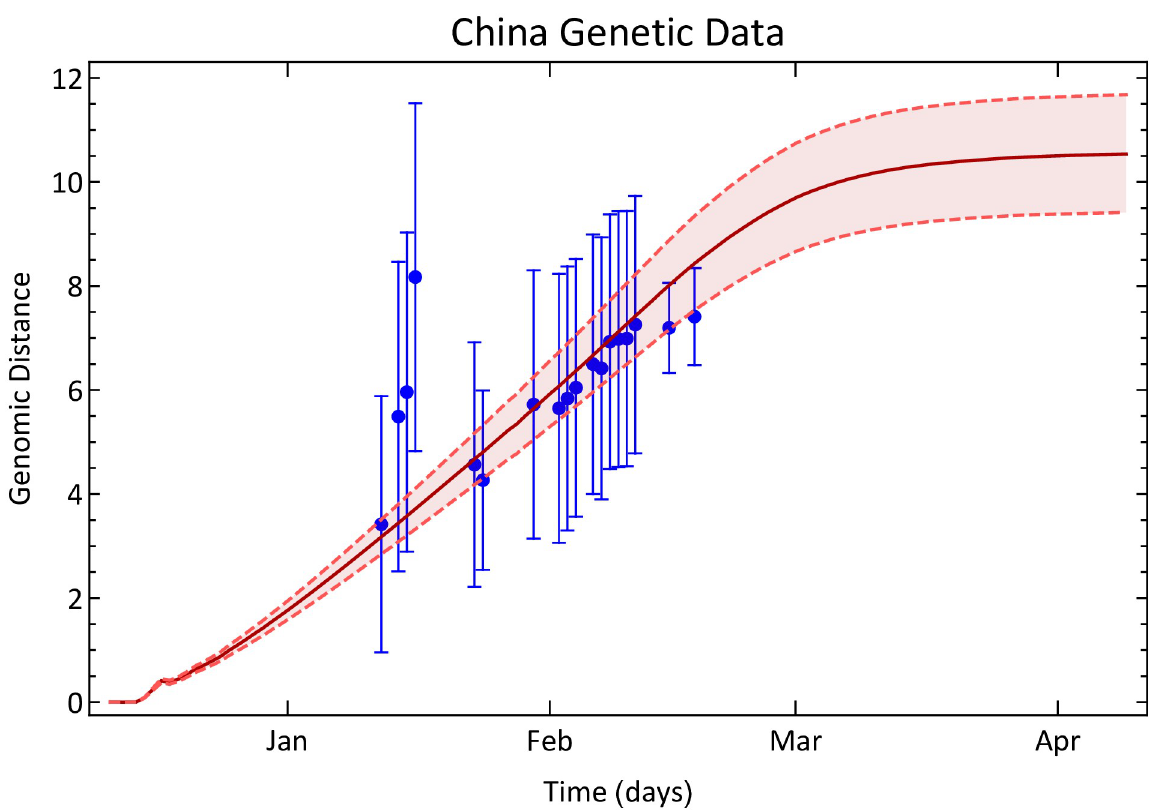
Fig 4. The genetic evolution of SARS-CoV-2 in China. Blue dots are the genetic distance among SARS-CoV-2 inferred from data collected in China between 12/23/2019 and 03/24/2020. The error bars are standard deviation of pairwise distance propagated through the equations. The brown line shows the genetic distance estimated with Eq (2) and the Chinese epidemic data. The interval around the brown curve is a ± 10% error interval on the value Bμ , which we considered to be Bμ = 29900 ×